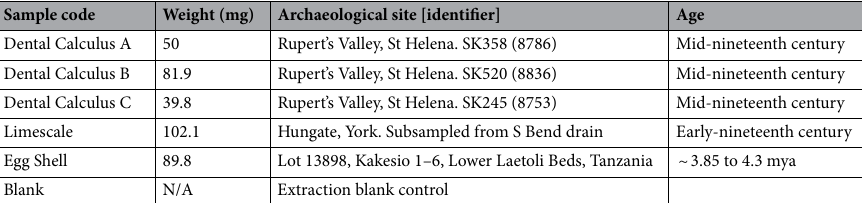
Table 1. Contamination experiment sample extracted and analyzed in this study.